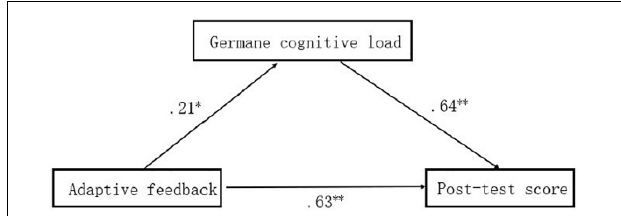
TABLE 3 | Correlation analysis.